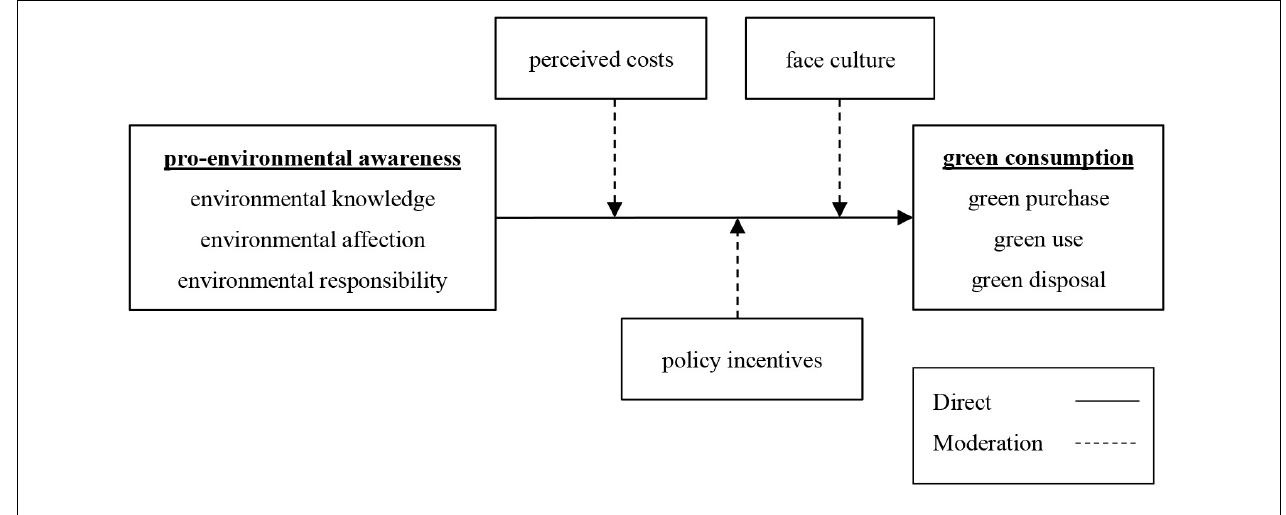
FIGURE 1 | Hypothetical model of the